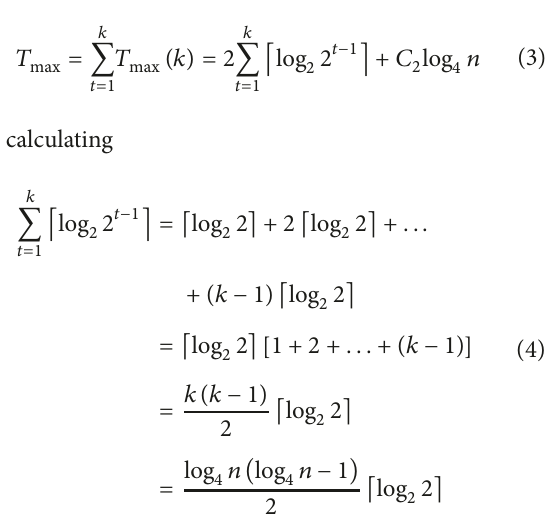
Figure 7: The following operations in the proposed flexible parallel merge of the temporary array into the input